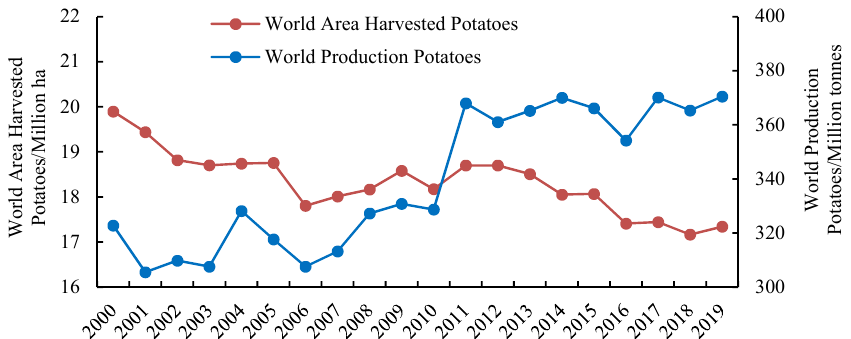
Figure 1. Production/yield quantities of potatoes in the world, 2000–2019. Date from reference [12] . Copyright 2021 FAO.